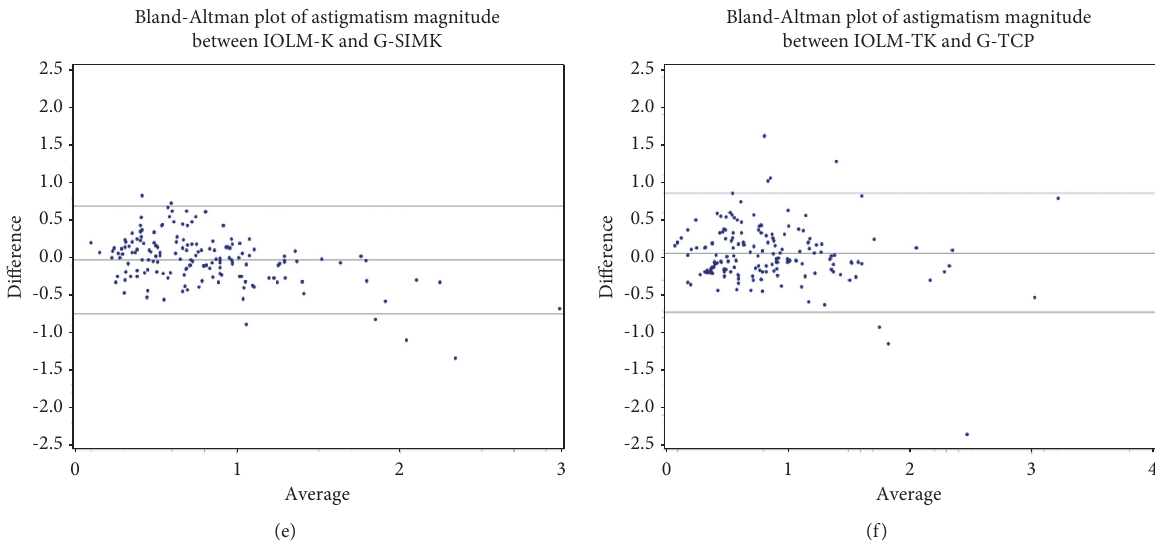
Figure 3: Bland–Altman plots depicting interdevice agreement in secondary endpoints: (a) flat SimK, (b) flat TrueK, (c) steep SimK, (d) steep TrueK, (e) SimK magnitude, and (f) TrueK magnitude. Horizontal lines depict mean ± 1.96 standard deviation (95% LOA) values. X -axis � diopters mean corneal power (a–d) and corneal astigmatism (e, f). Y -axis � difference in mean value